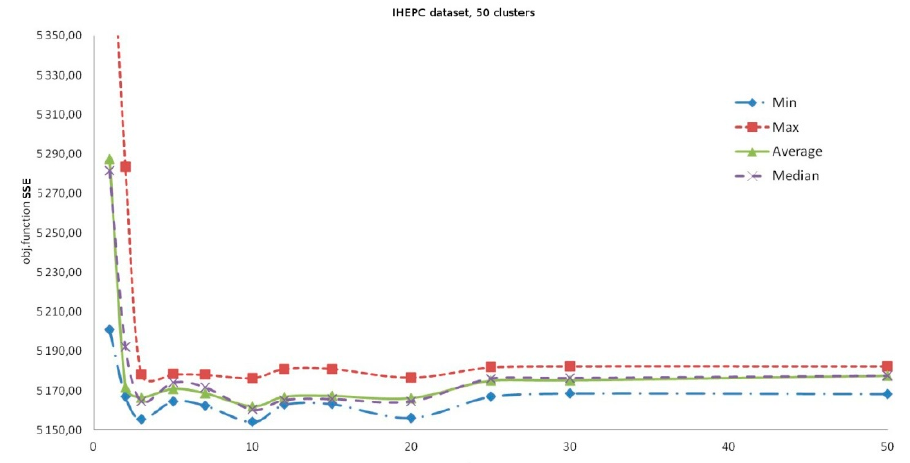
Figure 3. Search in GREEDY r neighborhoods. Dependence of the result on r : Individual Household Electric Power Consumption (IHEPC) data set, 50 clusters, 2,075,259 data vectors, time limitation 5 min.